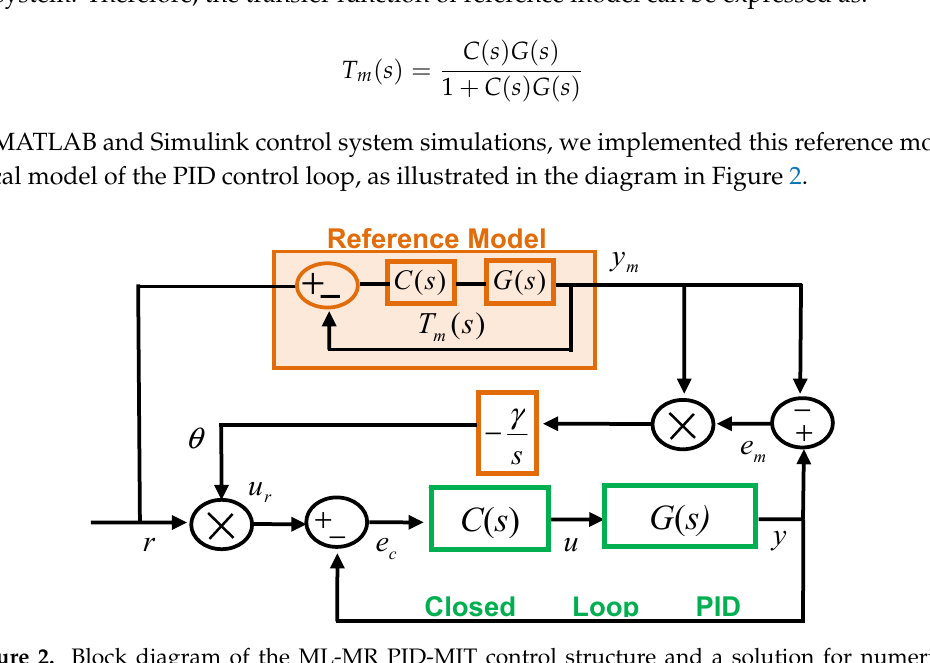
Figure 3. Comparison of disturbance rejection performance of ML-MR PID-MIT control and classical PID control for